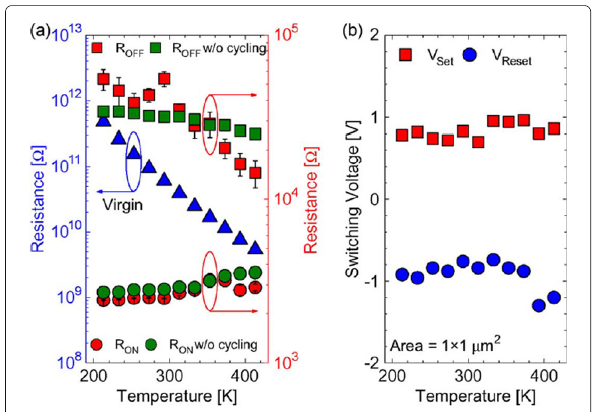
Fig. 9 The effect of varying temperature on a virgin resistance (left axis) and the OFF-state as well as the ON-state resistances (right axis) at 213–413K temperature range and b switching voltages V set and V reset ; reprinted from ref. [111]